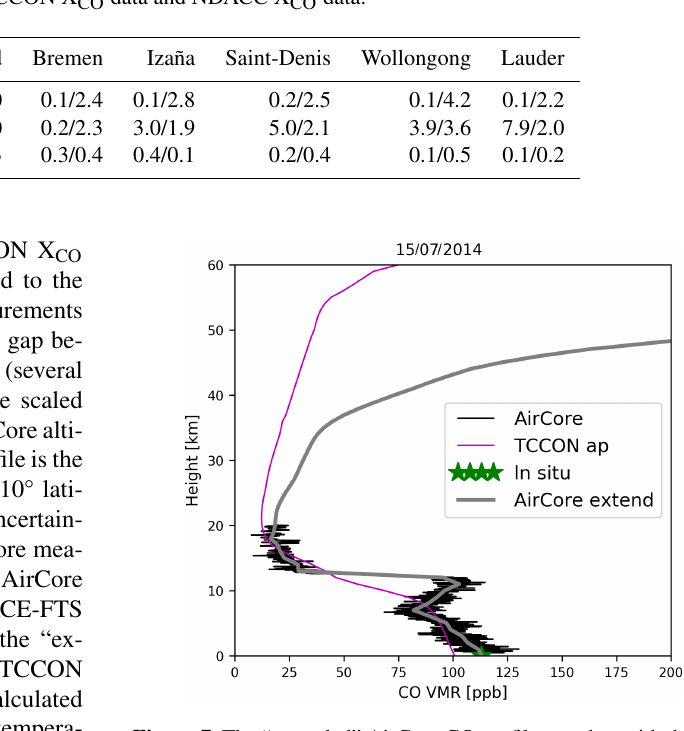
Table 5. The systematic and random smoothing errors of the difference between TCCON and NDACC X CO data (using scaled NDACC a priori profiles as the common a priori profile), standard TCCON X CO data and NDACC X CO data.